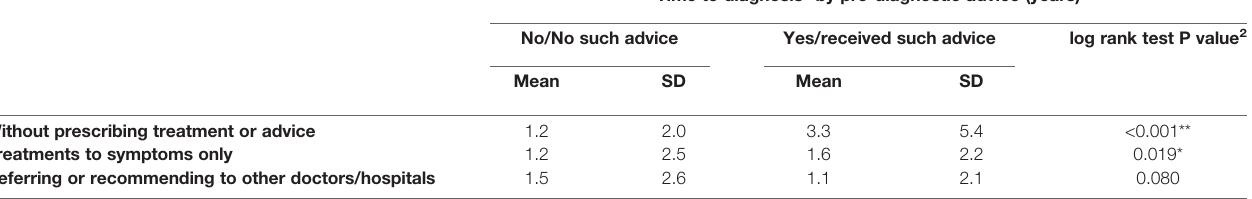
TABLE 3 | Length of diagnostic delay by different pre-diagnostic advices and